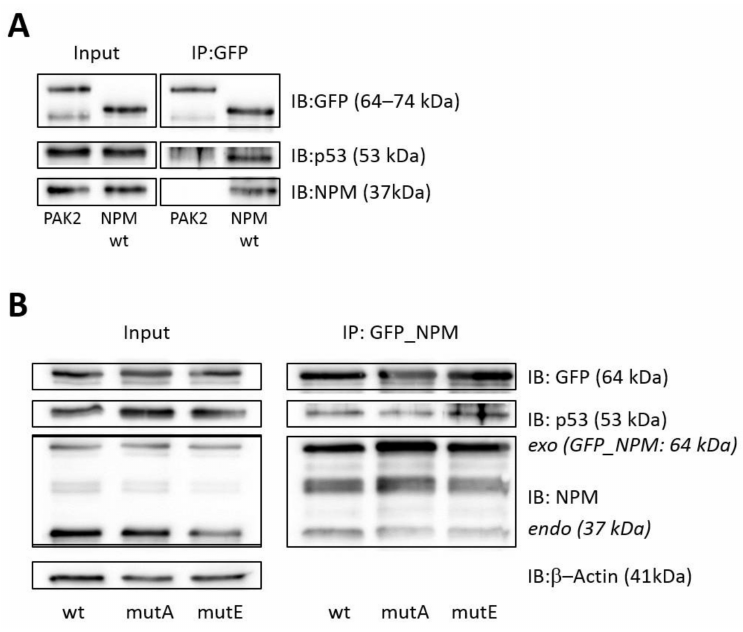
Figure 2. Interaction of p53 with NPM variants in lysates of HEK-293T cells. ( A ) Interaction of p53 with NPMwt. Cells were transfected with G_NPMwt or G_PAK2 (p53-non-interacting control of a comparable size). Endogenous NPM as well as p53 co-precipitated only with NPMwt; ( B ) interaction of p53 with NPMmut. Cells were transfected with eGFP-labeled NPMmutA, NPMmutE or NPMwt for comparison (see Methods, Section 2.2). Endogenous NPM, as well as p53, co-precipitated in all samples. The samples are identical with those used in [28] for assessment of the interaction between NPM and nucleolin. Reprinted with permission from Ref. [28]. Copyright Elsevier (2018). Abbreviations can be found in Table